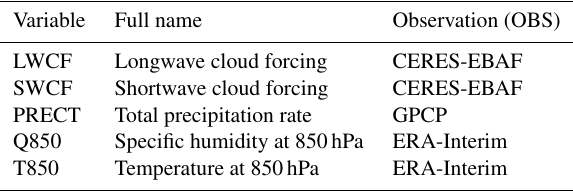
Table 2. The output variables used to evaluate performance metric index and the source of the corresponding